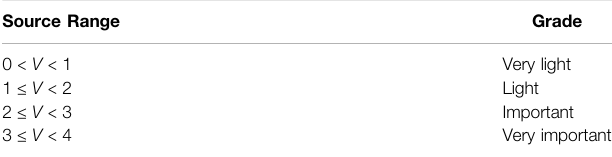
( Table 4 and Figure 3 ). In the Taibus Banner, ecological